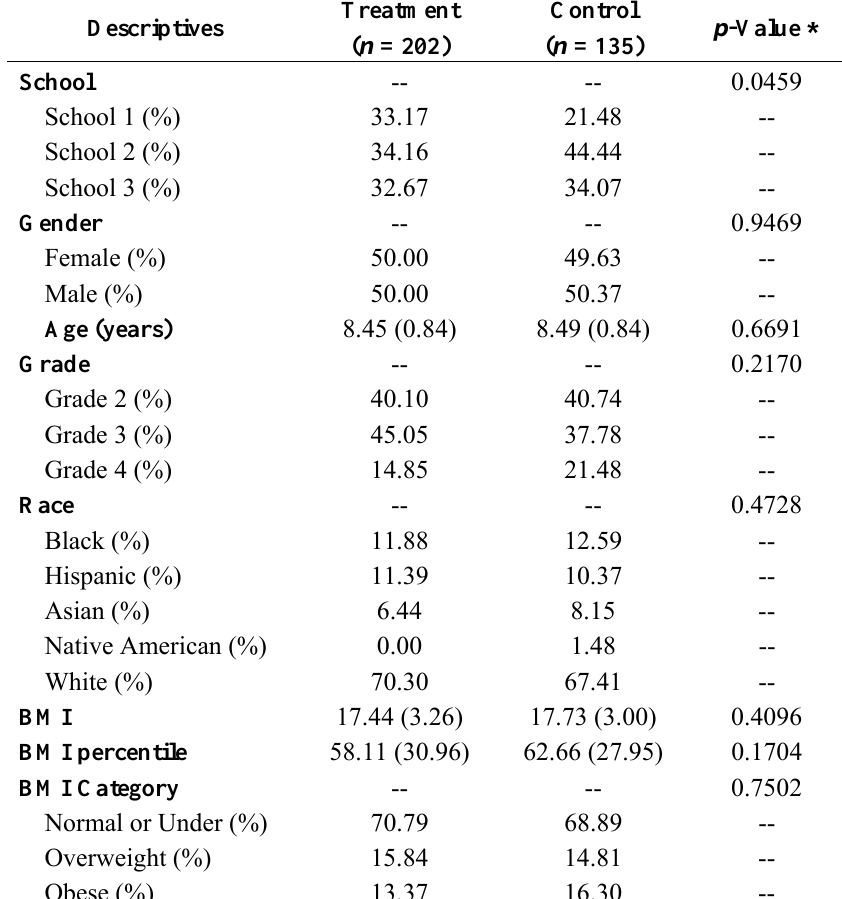
Table 2. Baseline characteristics for students participating in the study, expressed in means (standard deviation) or